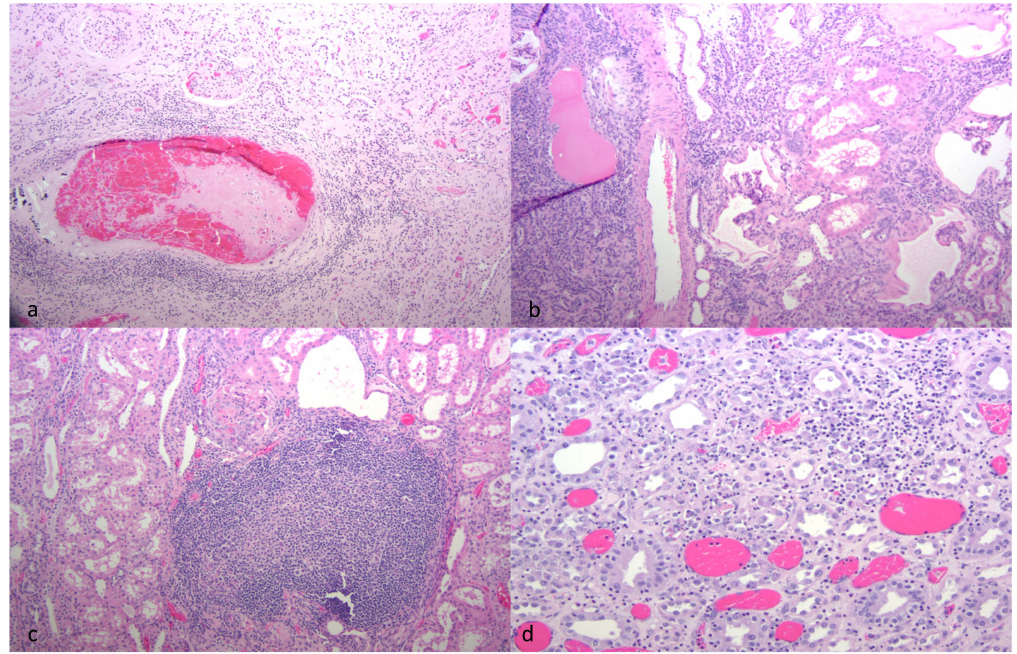
Figure 2. Histological features of CAEV-associated renal lesions (HE-stained sections). ( a ) A large artery at the corti- comedullary junction has a luminal thrombus and is cuffed by moderate numbers of lymphocytes, (thrombotic arteritis, goat A). ( b ) The renal interstitium is expanded by large numbers of mononuclear lymphocytes and plasma cells (interstitial nephritis, goat B). ( c ) The renal cortex has an organized lymphoid follicle expanding the interstitium of goat B. ( d ) The